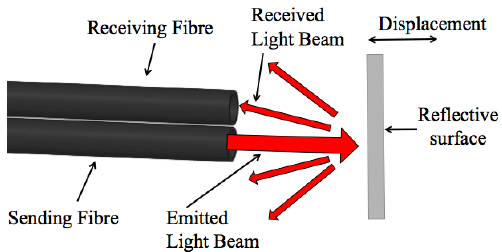
Figure 2. Measurement of the change of light intensity modulation using optical